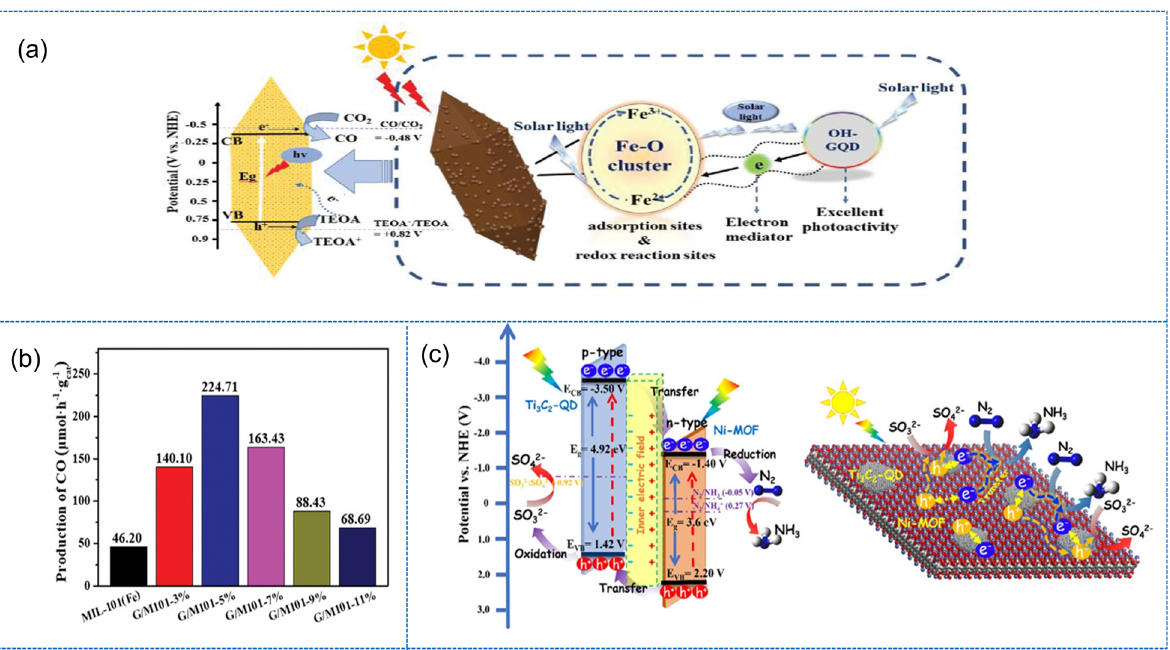
Figure 10: ( a ) Schematic representation for visible light - assisted reduction of CO 2 over G/M101 nanocomposite. ( b ) Photocatalytic CO production by GQDs/MIL - 101 ( Fe ) [ 186 ] . ( c ) Diagrammatic representation of energy band positions, localized charge separation, and movement through the photocatalytic N 2 reduction over Ti 3 C 2 - QDs/Ni - MOF [ 191 ]